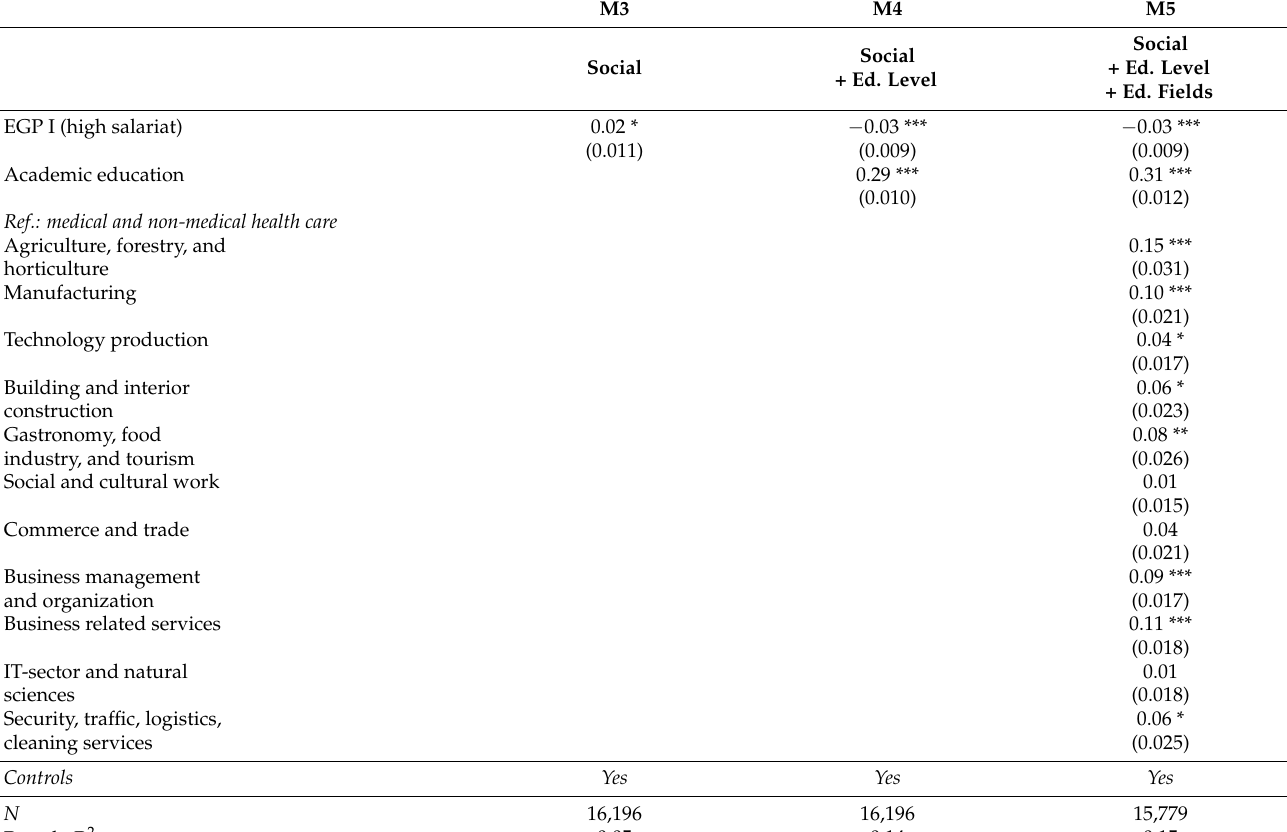
Table A2. Logit regression models of overeducation (objective indicator) on social background, educational level, and educational fields (AME) 1 .